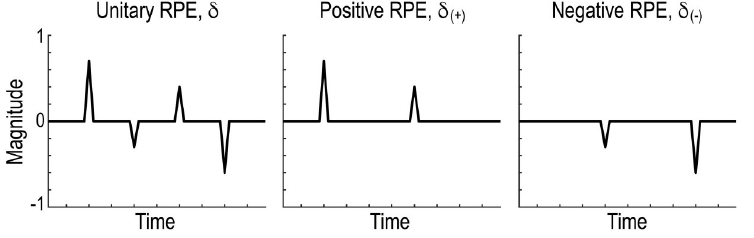
Fig 5. Schematic illustration of the three types of reward prediction error. Left , conventional unitary reward prediction error δ . Centre , positive reward prediction error, δ (+) = max ( δ , 0). Right , negative reward prediction error, δ ( − ) = min ( δ , 0). RPE, reward prediction